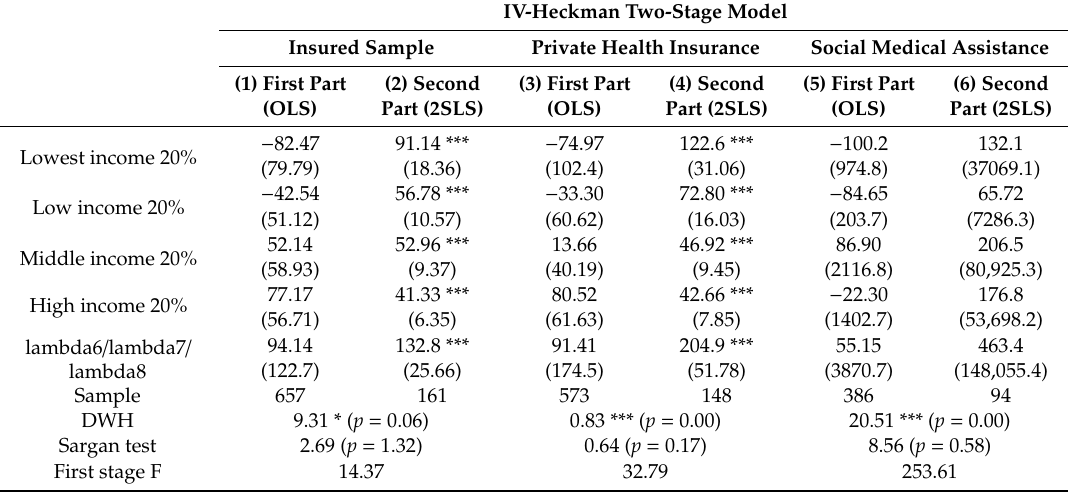
Table 7. Estimation of health care costs with di ff erent income and introduction of restricted